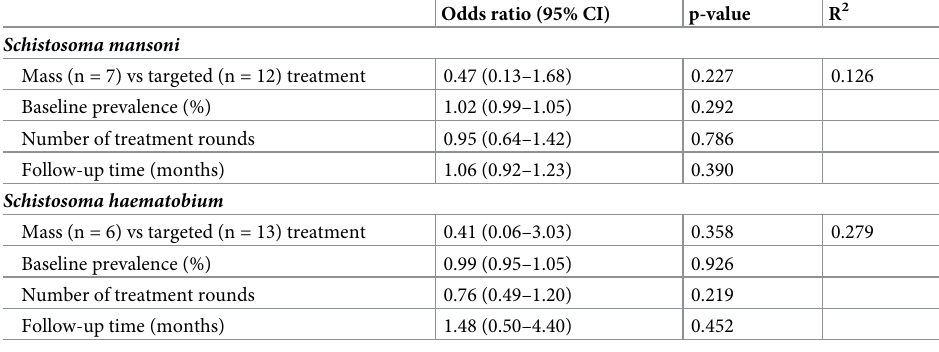
Table 3. Odds ratio of prevalence reduction � for selected covariates, stratified by Schistosoma species (inverse var- iance weighted generalised linear model with robust error variance).